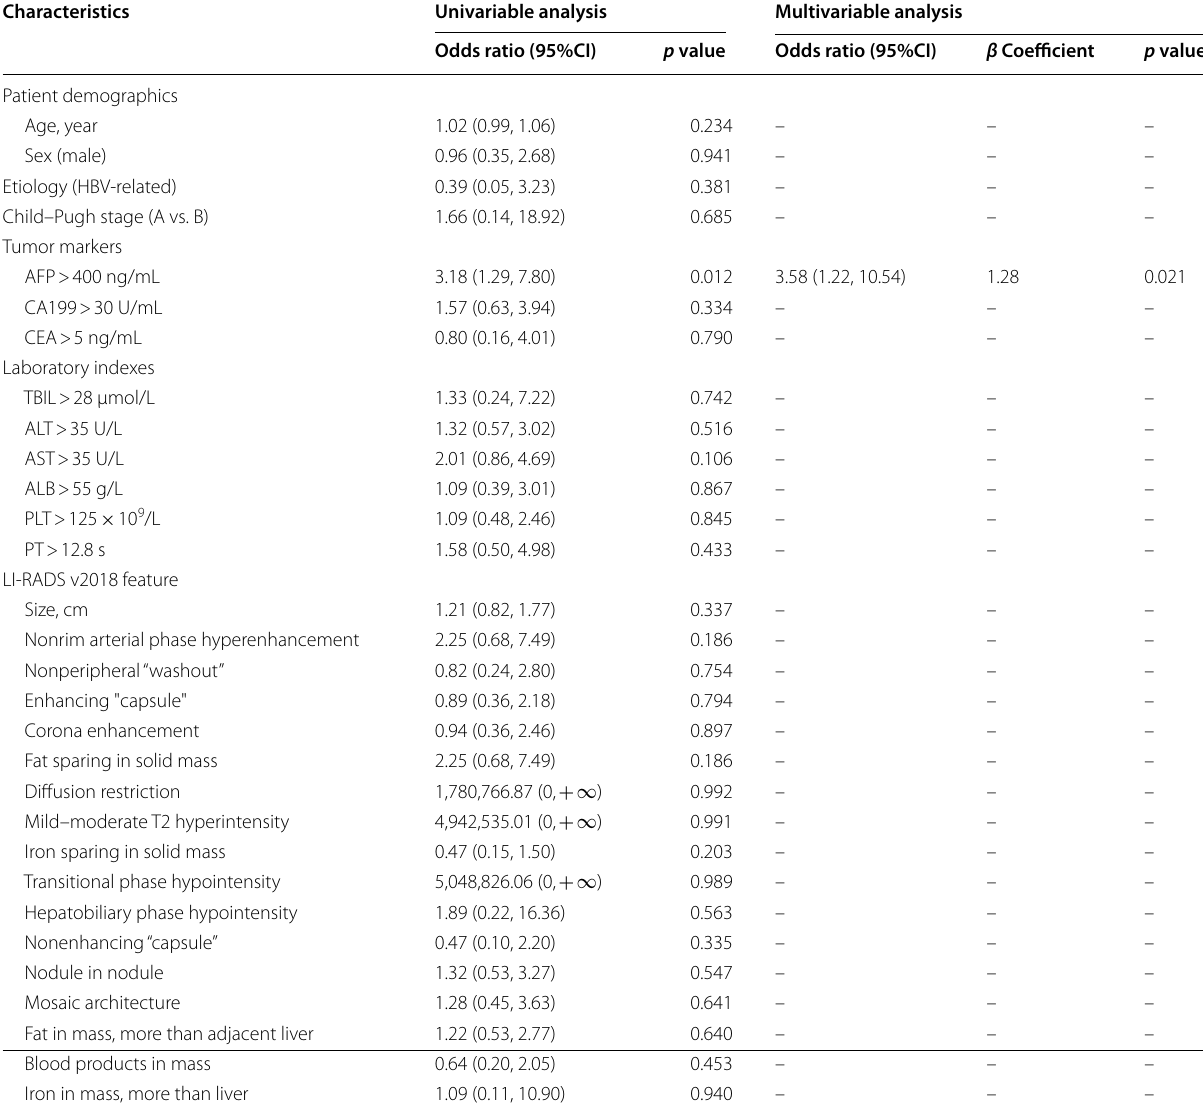
Table 3 Univariable and multivariable logistic regression analyses of predictors for histological differentiation of hepatocellular carcinoma on training